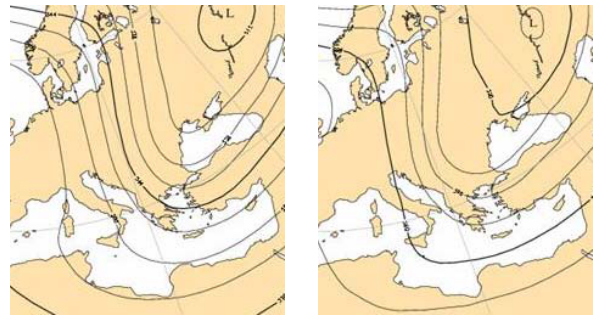
Fig. 3. 500hPa mean EPS geopotential height contours (contour interval 10dam) for 16 February 2008 at 1200UTC based on 12 February (left) and 14 February (right) 1200UTC-cycle.